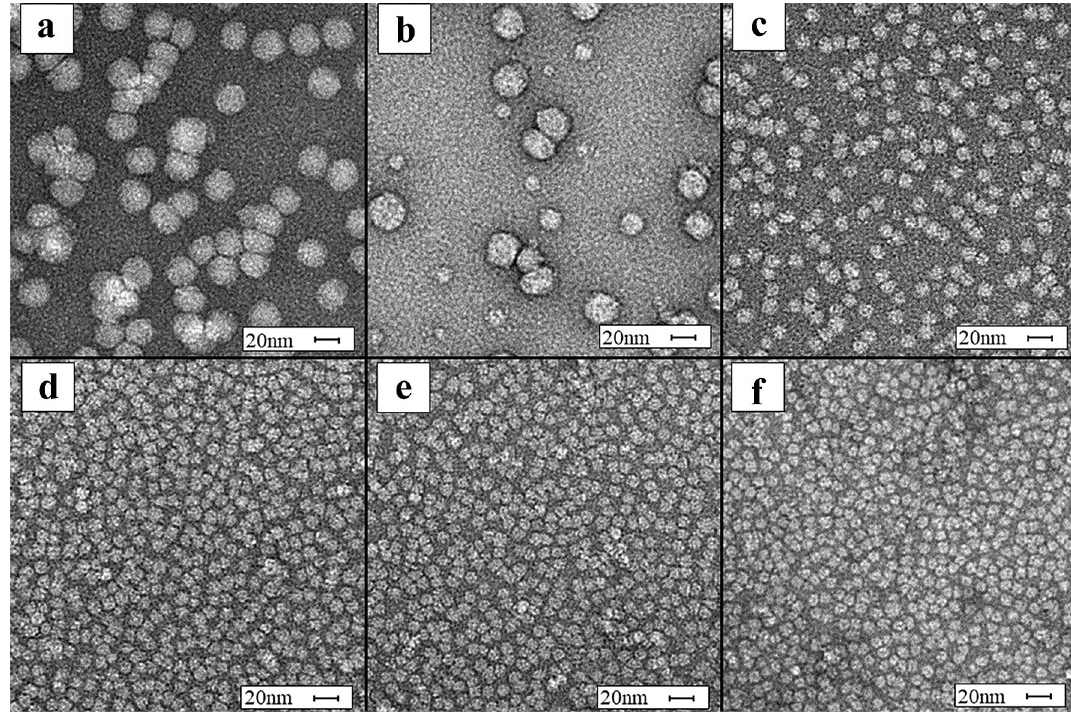
Figure 7. Transmission electron microscopy micrographs of size exclusion chromatography (SEC) fractions. All fractions are displayed with a size bar of 20 nm. ( a ) Fraction F1 shows particles ranging in size from 18 to 28 nm. ( b ) Fraction F2 shows primarily particles in the size range of 18–28 nm, and some particles in the size range of 7–12 nm. ( c ) Fraction F3 shows particles in the size range of 7–18 nm, ( d ) Fraction F4 shows particles in the size range of 7–15 nm, ( e ) Fraction F5 shows particles in the size range of 7–12 nm, and ( f ) Fraction F6 shows particles in the size range of 7–10 nm. Fraction F7 is not displayed because no particles were visible in this